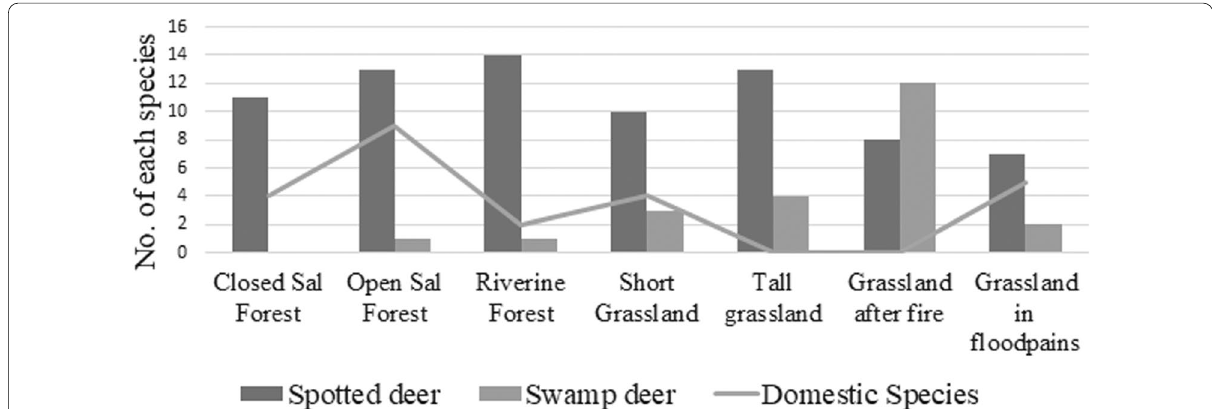
Fig. 3 Interaction of domestic cattle with wild species in different habitat types. Interaction of domestic cattle with wild species was very high in Shorea robusta